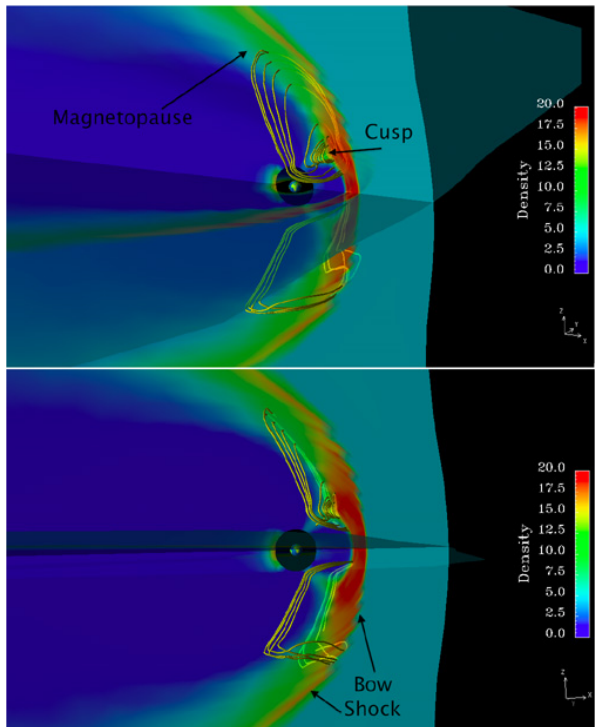
Fig. 1. Chapman-Ferraro current streamlines as determined from the LFM magnetosphere simulation under nominal solar wind con- ditions ( V = 400kms − 1 , n = 5cm − 3 , B z = − 5nT) with density (cm − 3 ) color-coded in the translucent XY- and XZ-planes. The GSM coordinate system is shown in the lower right corner. The sense of the current circulation is counterclockwise (as viewed from the Sun) in the Northern Hemisphere and clockwise in the South- ern Hemisphere. The Northern Hemisphere current includes a por- tion of the cusp current, tightly wound in the center of Chapman- Ferraro current system. The Southern Hemisphere current shows the connection between the bow shock current and the low latitude Chapman-Ferraro